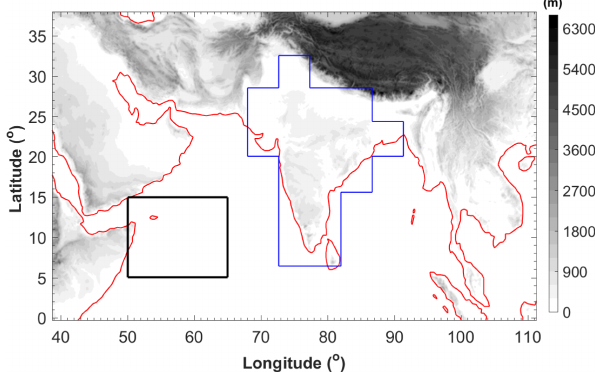
Figure 1. Model domain used in the WRF simulations with topog- raphy (grayscale) and coastlines (red lines). The black box shows the climatic zone used for the calculation of KELLJ index and the blue polygon shows the Indian